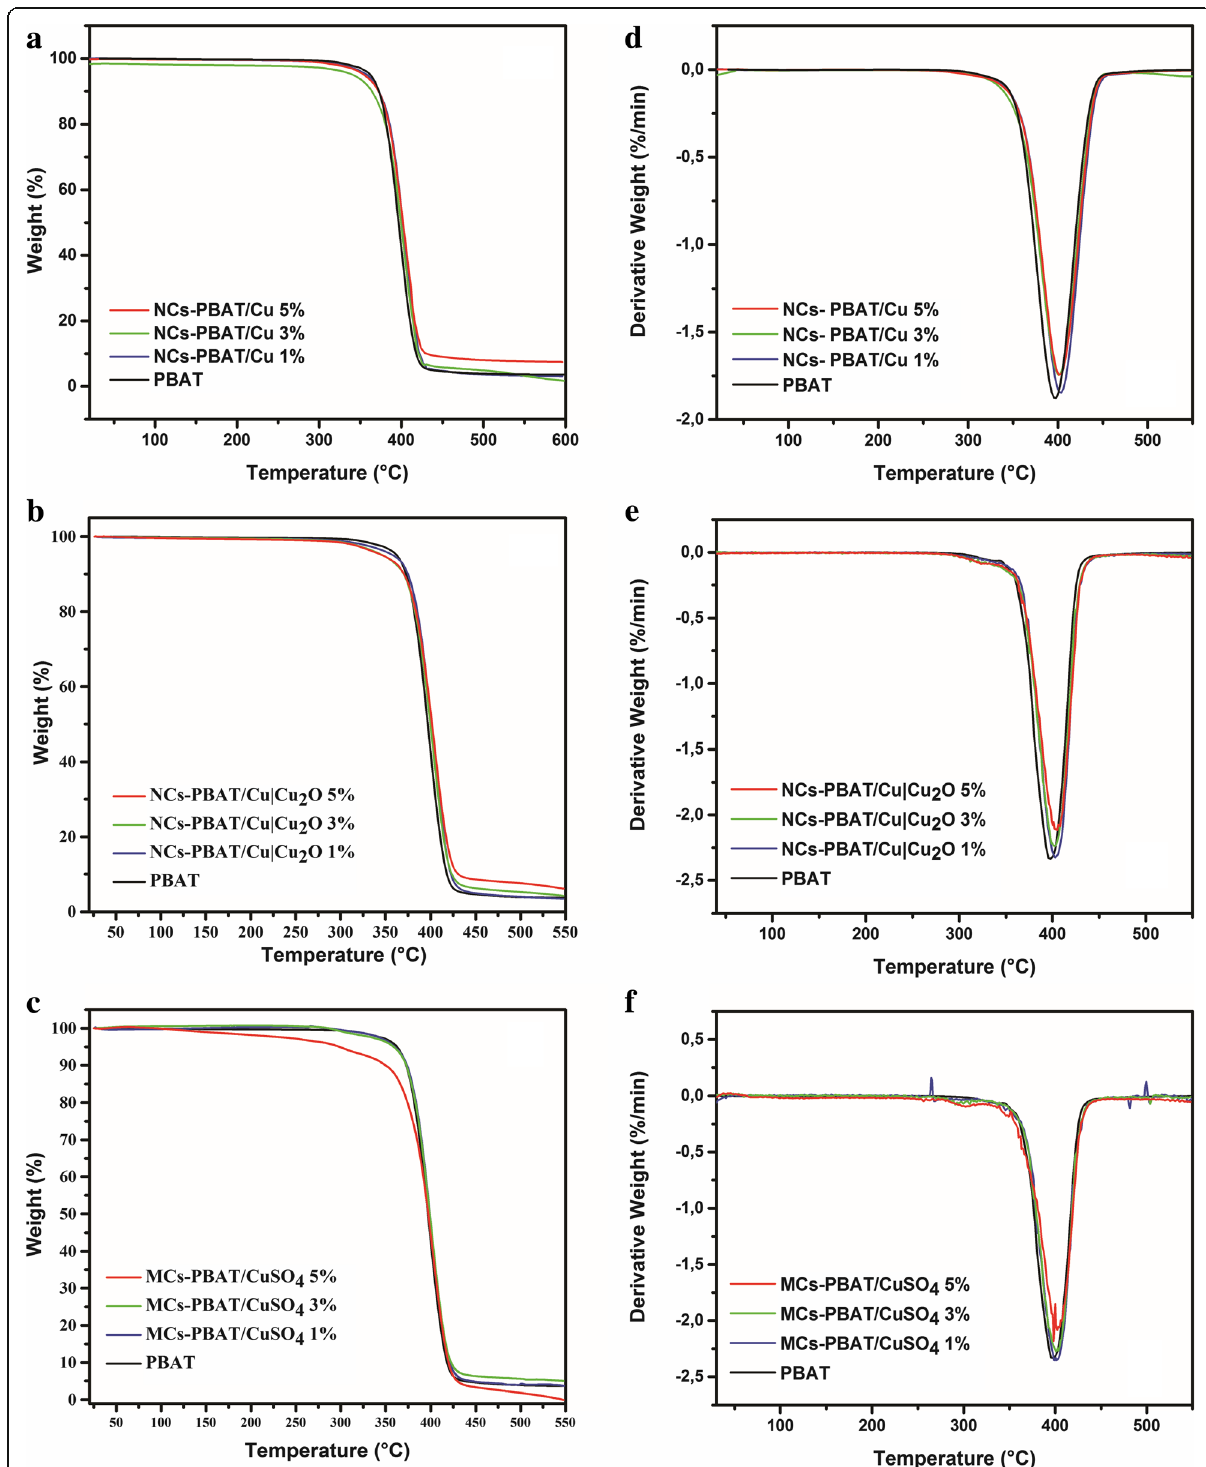
Fig. 4 TGA of a PBAT and NCs-PBAT/Cu, b NCs-PBAT/Cu|Cu 2 O, and c MCs-PBAT/CuSO 4 , DTG of d PBAT and NCs-PBAT/Cu, e NCs-PBAT/Cu|Cu 2 O, f MCs-PBAT/CuSO